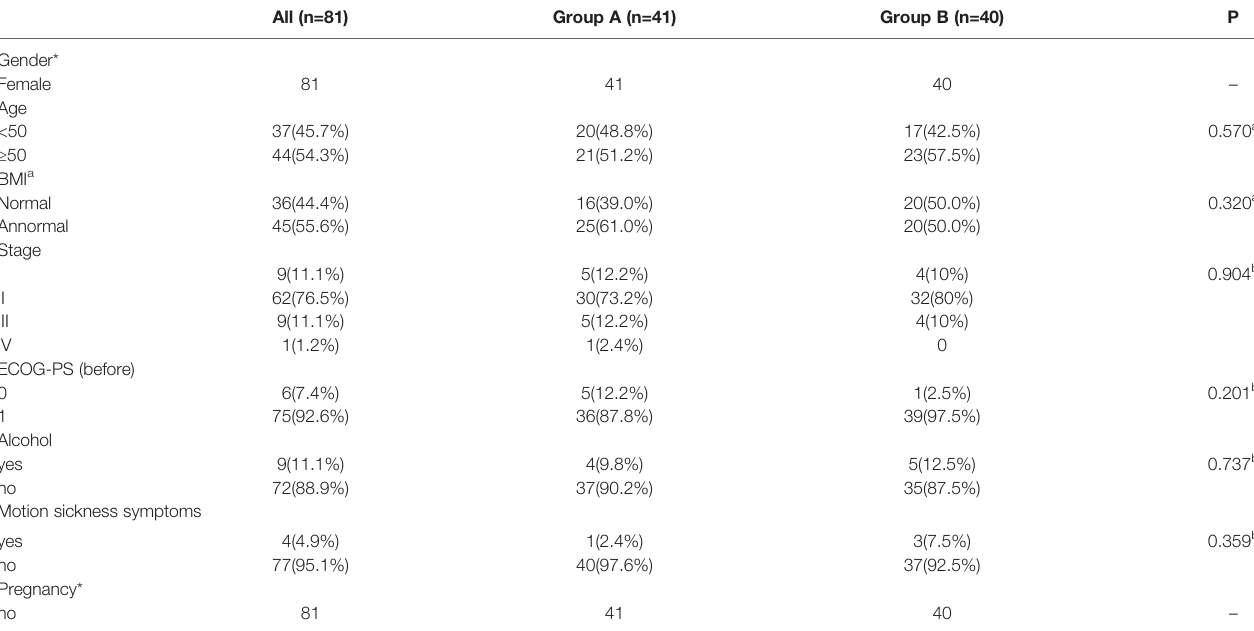
TABLE 1 | The basic information of 81 patients with following a curative resection for breast